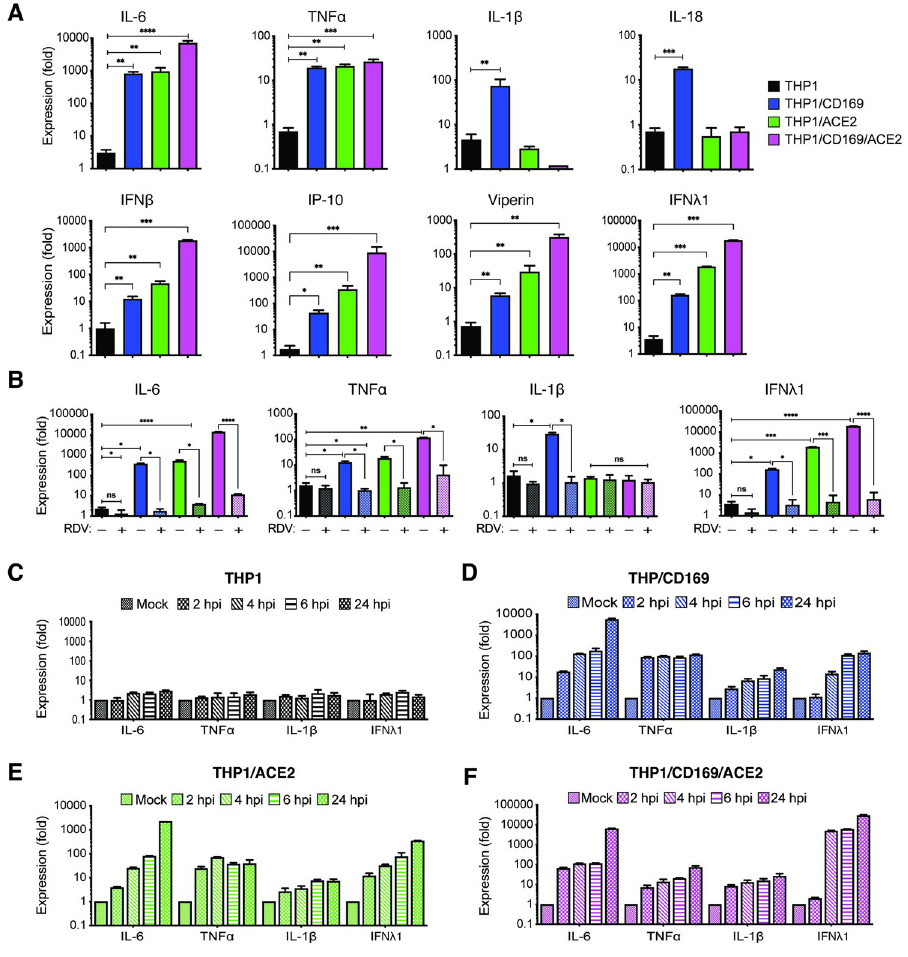
Fig 6. Restricted de novo expression of SARS-CoV-2 RNA induces pro-inflammatory responses in non- productively infected THP-1/PMA macrophages. ( A - B ) PMA-differentiated THP1 cells from parental (THP1) or those expressing CD169, ACE2, or CD169/ACE2 were infected with SARS-CoV-2 (MOI = 1, 24 hpi) in the absence or presence of RDV (1 μ M), and total RNA was analyzed by RT-qPCR for pro-inflammatory cytokine and ISG expression. Values were normalized to mock-infected control for each group. Fold-induction for indicated pro- inflammatory cytokines ( A , top panel) and ISGs ( A , bottom panel) in the absence of RDV, or in the presence of RDV ( B ). ( C - F ) Kinetics of pro-inflammatory cytokine/ISG mRNA expression in the absence of RDV in parental ( C ), CD169-expressing ( D ), ACE2-expressing ( E ), and CD169/ACE2-expressing ( F ) THP1/PMA cells. The means ± SEM are shown from at least 3 independent experiments. Significant differences between groups were determined by one- way ANOVA followed by the Dunnett’s post-test ( A - B ),comparing to control parental THP1 cells. P -values: � < 0.1; �� < 0.01; ��� < 0.001; ���� < 0.0001; ns: not